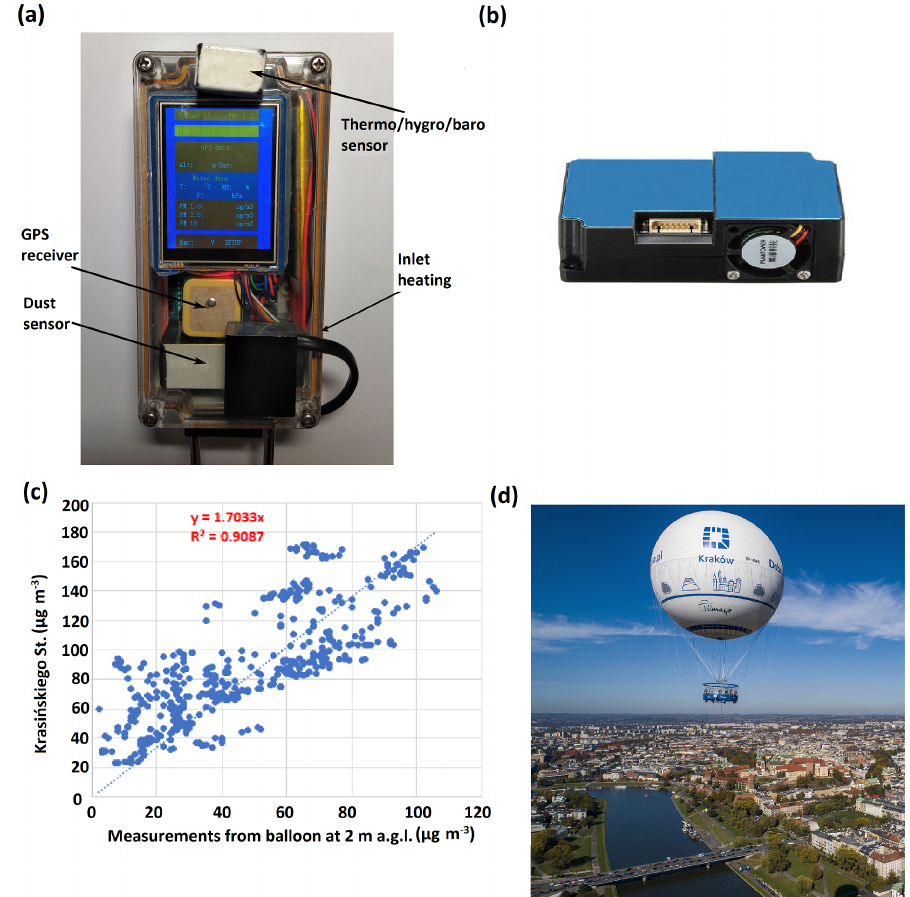
Figure 3. Self-designed and built air pollution measuring system (a) , low-cost sensor Plantower PMS1003 PM component (b) , correlation of measurements from balloon location and closest air pollution station (Krasi´nskiego St.) with fitted regression curve and R squared factor (c) and (d) sightseeing balloon (source: http://balonwidokowy.pl, last access: 21 April 2021). Table 2. Locations of meteorological stations in Kraków and its vicinities, station Kasprowy Wierch, balloon measurement point and mete- orological elements used in the